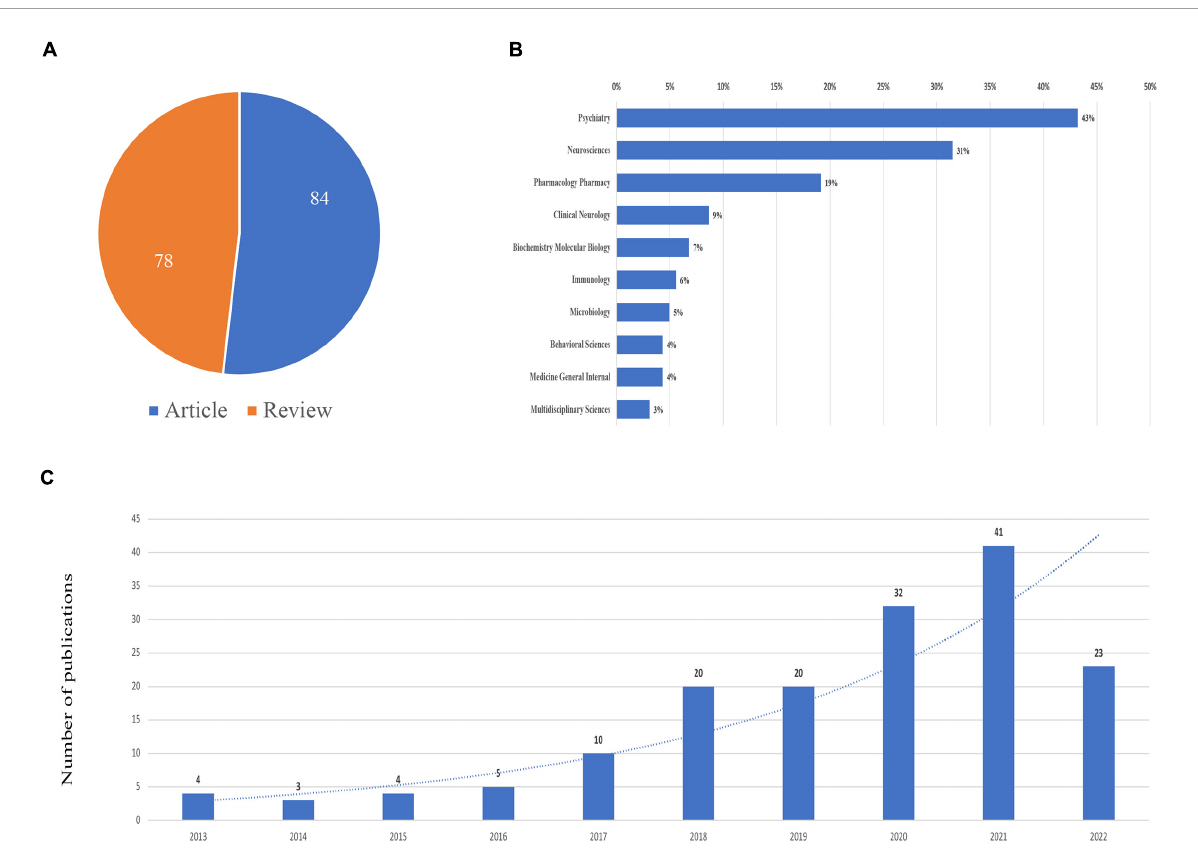
FIGURE2 Publications on schizophrenia and gut microbiota from inception to 2022. (A) Literature types distribution. (B) Subject categories distribution. (C) Annual publications quantitative